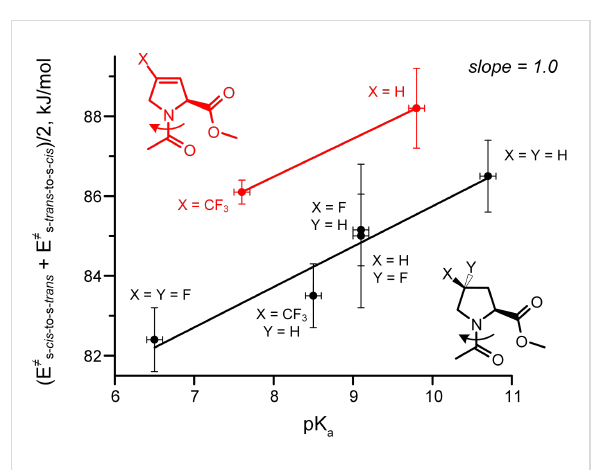
Figure 3: The double bond between C 3 and C 4 atoms in 3,4-dehy- droproline residues induces an increase in the amide rotational barriers in